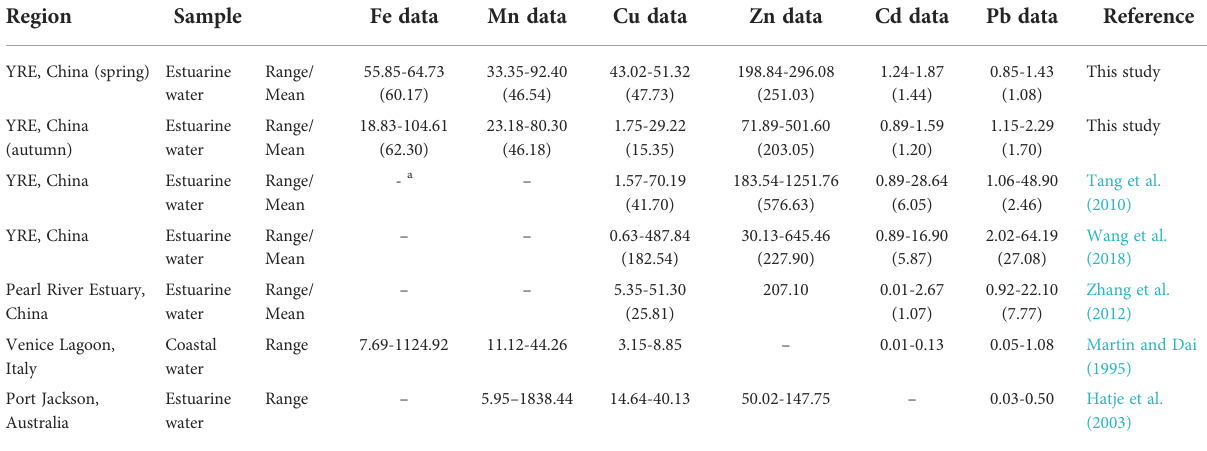
TABLE 2 The summary of Fe, Mn, Cu, Zn, Cd and Pb) concentrations in the water of the Yellow River Estuary (YRE) and other estuarine systems in the world (nmol L -1 ).